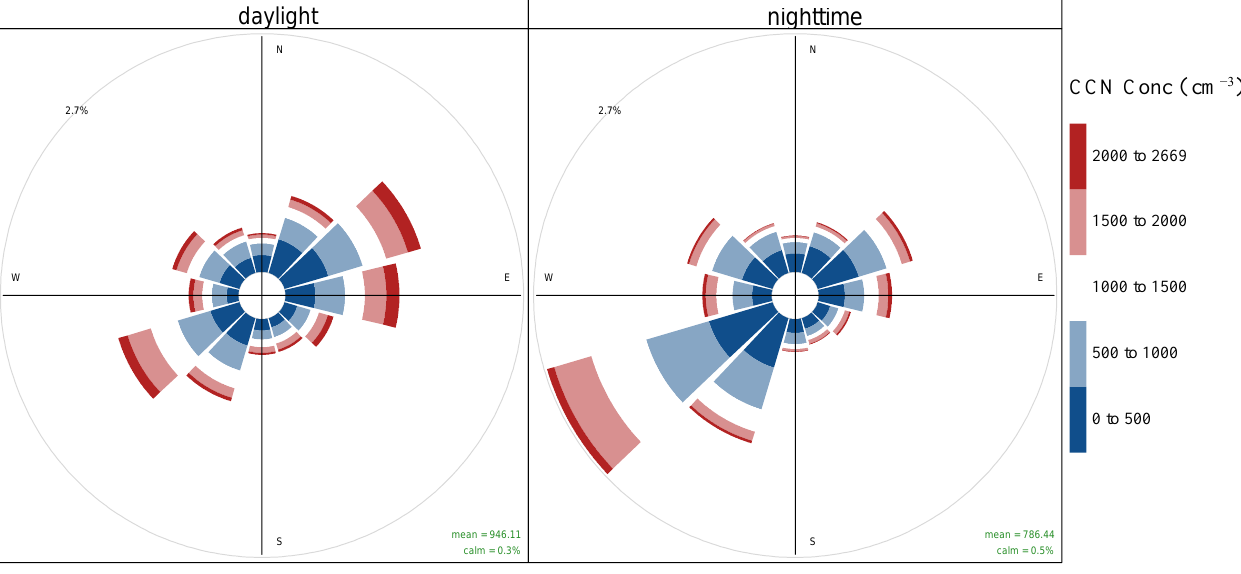
Figure 8. Contribution of wind directions to CCN concentration during daylight and nighttime.